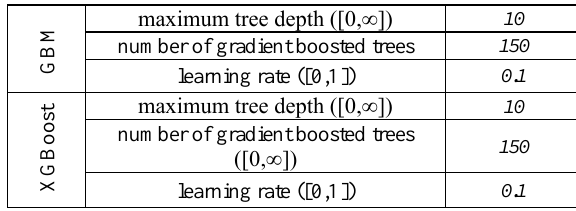
Table 2 . Hyper-parameter tuning of classifiers.